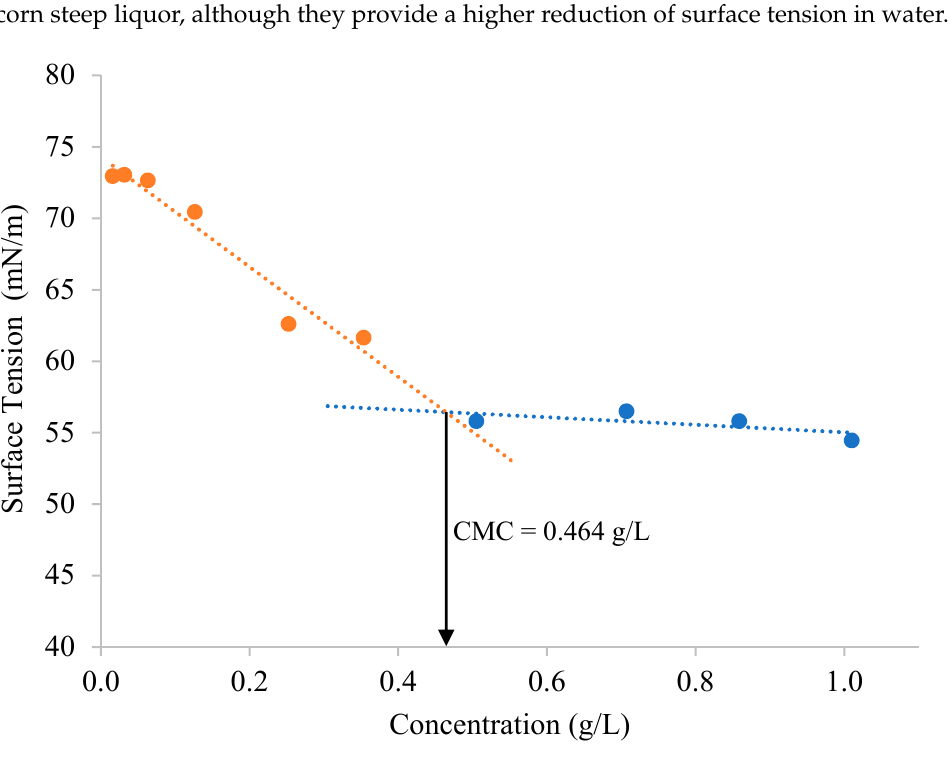
Figure 2. Critical micellar concentration (CMC) of corn steep water before adsorption processes. The concentration at which the micellization starts is known as CMC. At this con- centration not only the micelles are made, but also the lower surface tension value of the solution is achieved [40]. Thus, after the adsorption processes, with the calcium alginate- based biopolymers, the CMC values increased almost two-fold, being 0.99 and 1.15 g/L for the biopolymer based on calcium alginate and calcium alginate tunned with grape marc, respectively; whereas the minimum surface tension remained constant (54.2–55.3